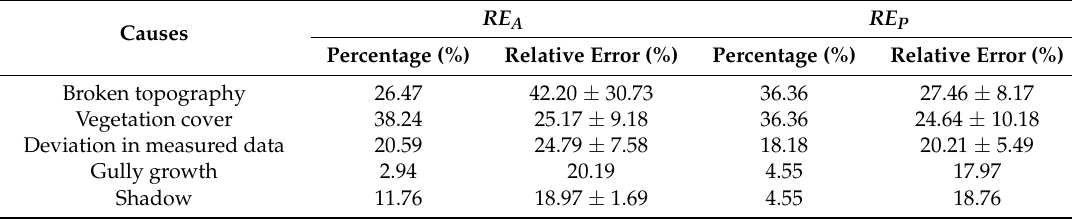
Table 3. Statistics of main causes to higher gully interpreting errors.